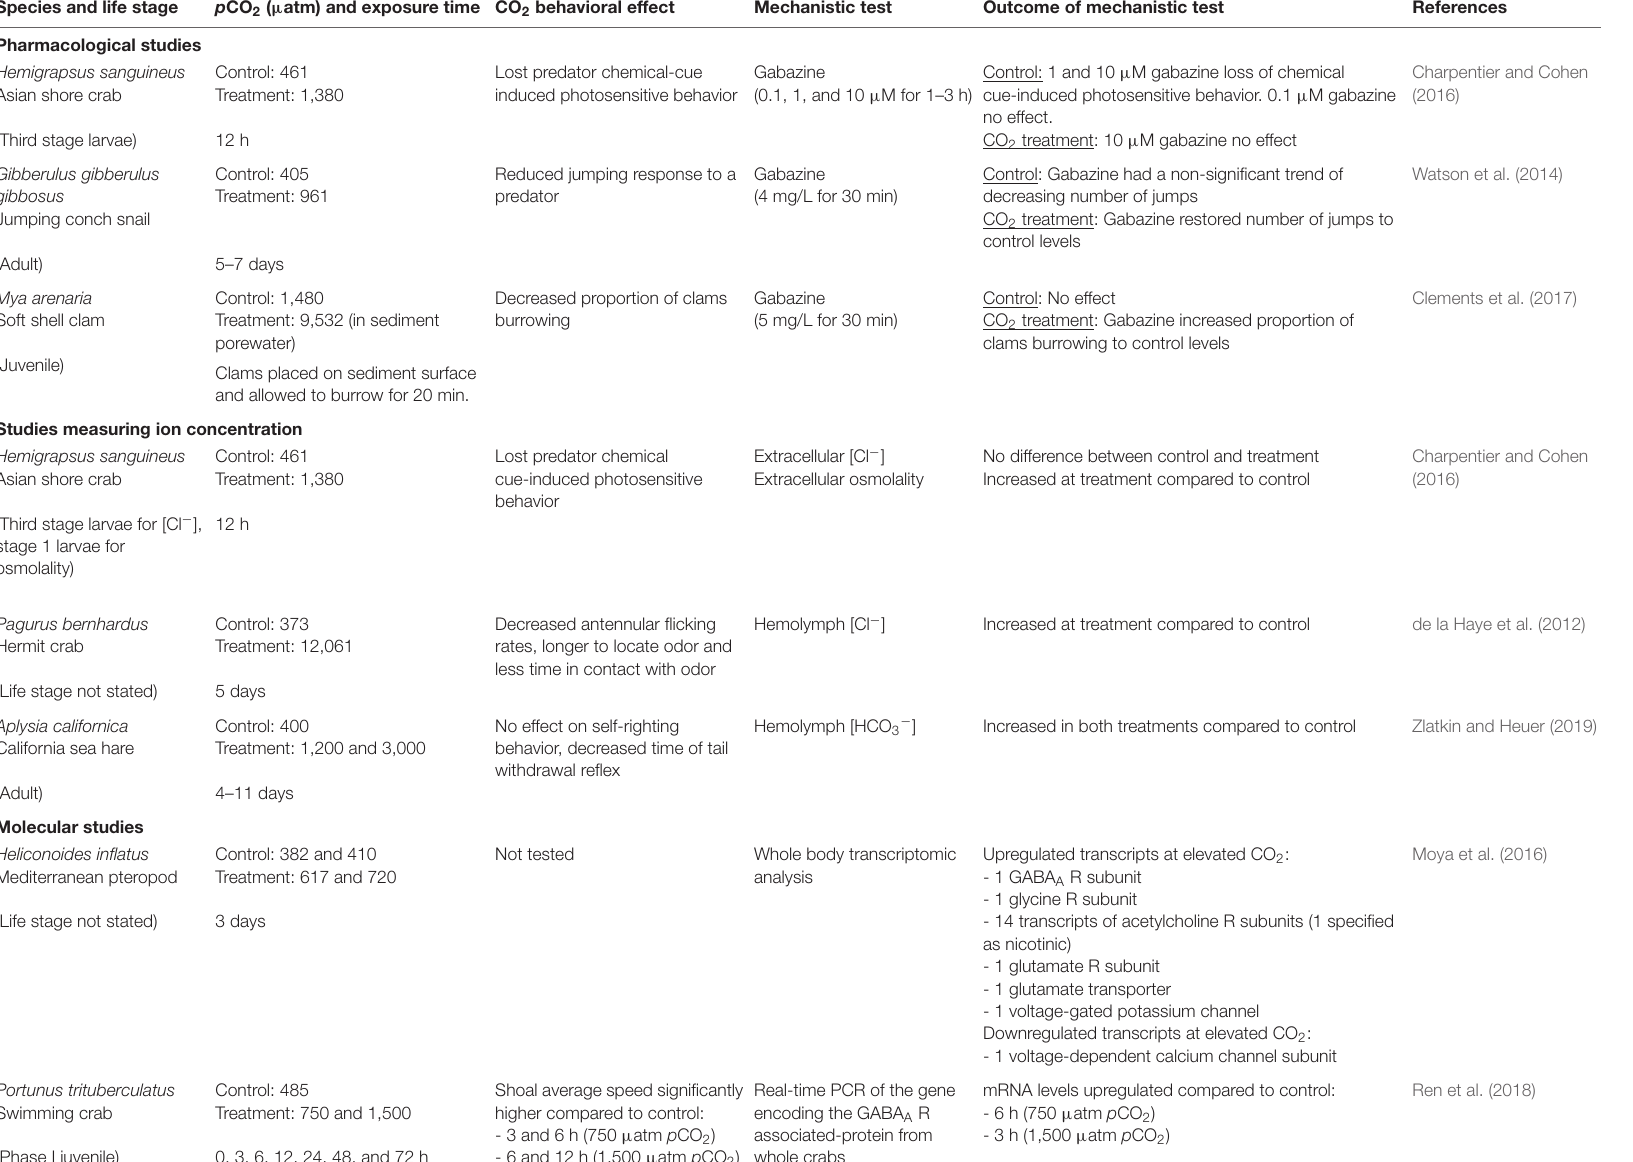
TABLE 1 | Summary of publications that have mechanistically tested whether LGIC-mediated neurotransmission is altered in marine invertebrates at elevated CO 2 . Species and life